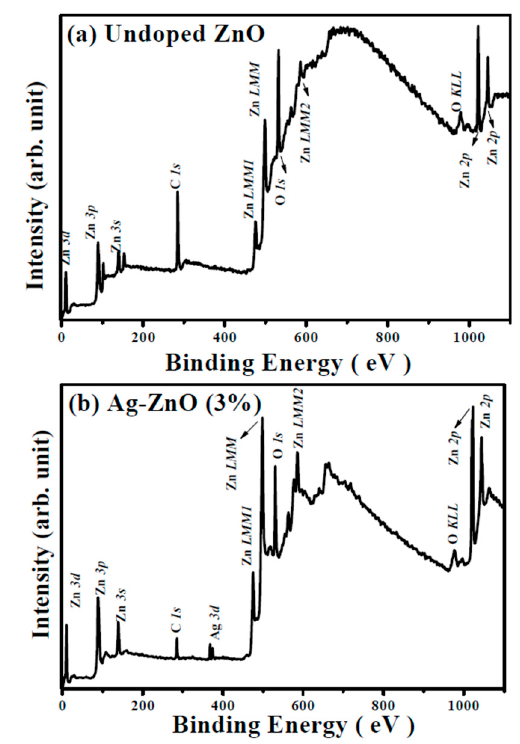
Figure 6. XPS survey spectra taken on the surface of the ( a ) undoped ZnO film and ( b ) Ag-ZnO co-sputtered film at a theoretical atomic ratio of 3% after annealing at 350 °C for 1 h under ambient air.